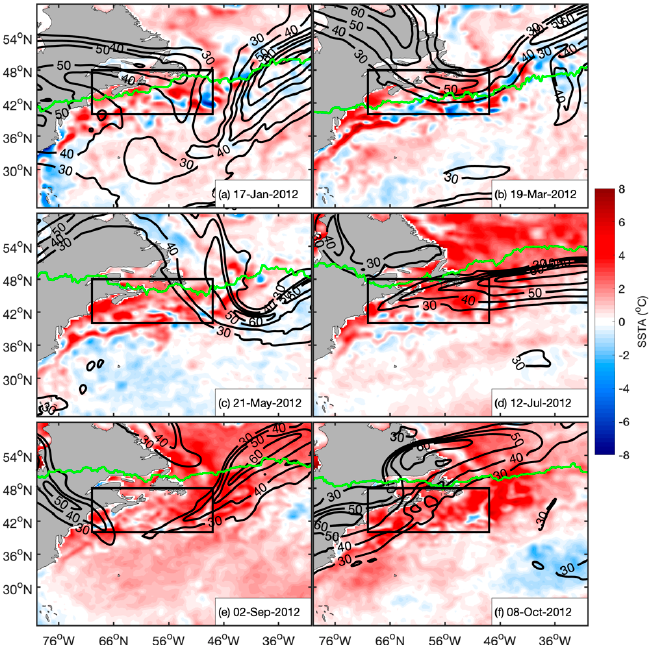
Figure 1. Spatial map of SSTA (°C) in the NW Atlantic throughout 2012. Black contour lines indicate wind speeds (m/s) at 300 hPa and the location of the Jet Stream. Green lines show the mean Jet Stream position based on the daily wind speed at 300 hPa from 1981–2020. Time series data was averaged over 40–48°N and 70–68°W indicated by the box. From the beginning of 2012 to March 2012, strong positive SSTA anomalies are spa- tially contained to the Center Slope and Center Shelf, specifically in the (40–48°N, 48– 70°W) box which we focus on throughout this study (Figure 1a, average = 1.15 °C; Figure 1b, average = 1.13 °C). Figure 1c shows the peak of the MHW intensity within the GOM in late May (average = 1.95 °C), with the JS meandering above the climatological mean position above the GOM and GSL. Throughout the rest of the year (Figure 1d, average = 2.10 °C; Figure 1e, average = 2.01 °C; Figure 1f, average = 2.47 °C), the positive SSTAs extend throughout the entire NW Atlantic, as the MHW fully formed, coinciding with the climatological northward movement of the JS. While the JS position from summer through the end of 2012 is not north of the climatological mean, the anomalous position occurred during the formation of this MHW in the first half of the year [14], and the extension of the event away from the coastline.